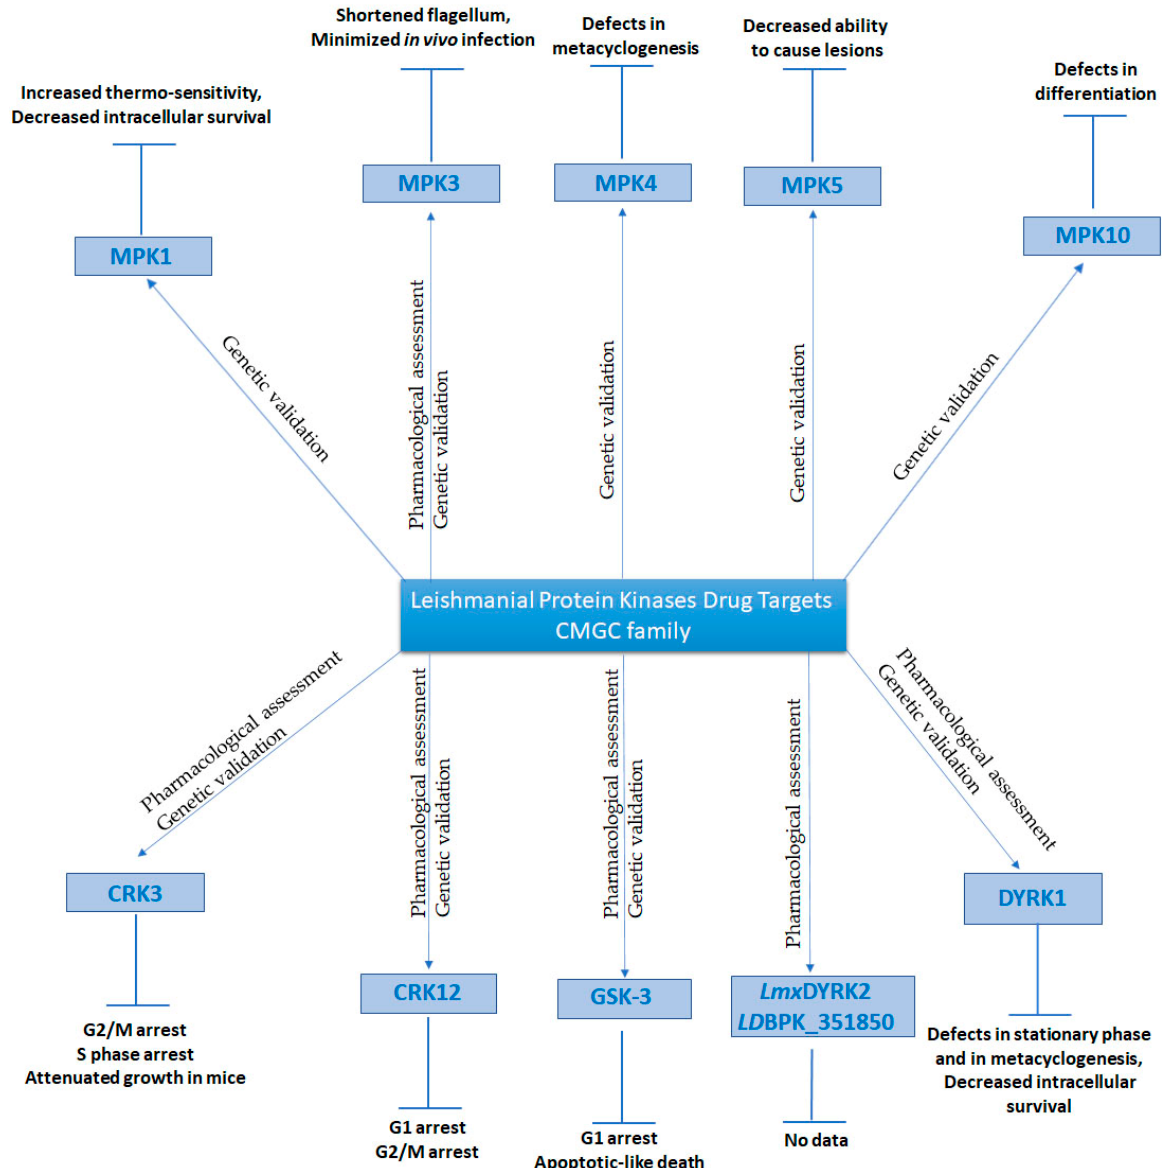
Figure 2. Leishmanial Protein kinases from CMGC family that could serve as drug targets . The ePKs displayed have been genetically and/or pharmacologically validated. The effects on their biological role and/or on their virulence upon pharmacological and/or genetic inhibition are also displayed in the diagram. Table 1. Identified inhibitors targeting leishmanial eukaryotic Protein Kinases.